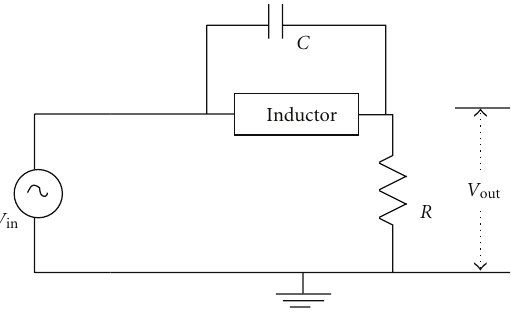
Figure 13: Band-stop filter.